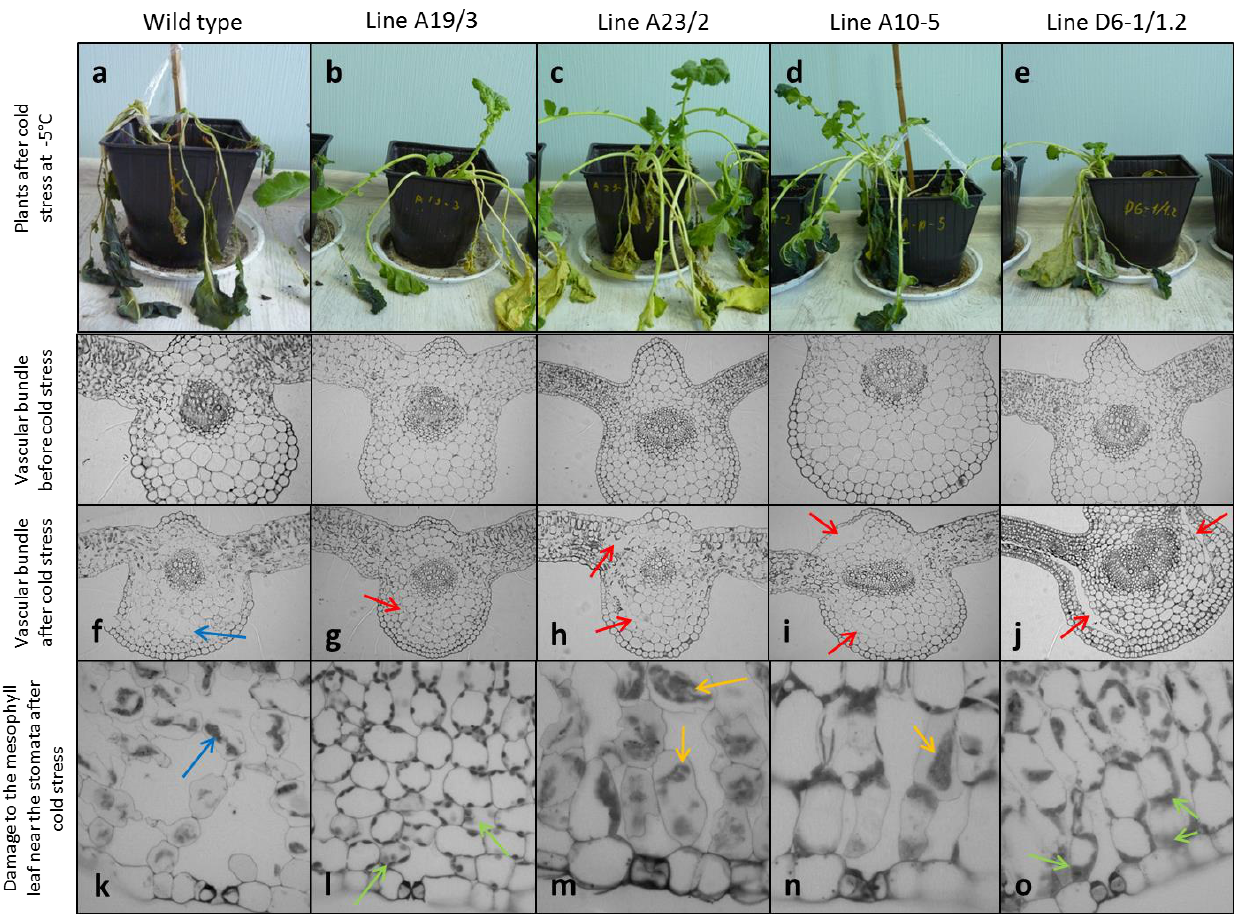
Figure 9. Light microscopy of non-hardened leaf tissue (surviving transgenic lines [A19/3 ( b ), A23/2 ( c ), A10-5 ( d ), and D6-1/1.2 ( e )] and wild-type ( a ) plants before (35-day-old plants) and after freezing at − 5 ◦ C according to the program shown in Figure 3c (37-day-old plants). Table 1. Loss of electrolytes from leaves of non-hardened transgenic plants and non-transgenic plants on the first day after 24 h exposure at negative temperatures and water content in the same plants a week after exposure at negative temperatures relative to plants without